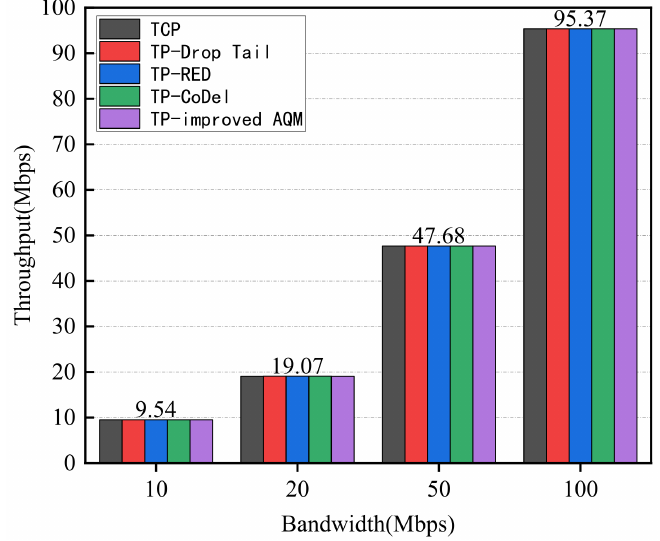
Figure 7. Bandwidth utilization under different bottleneck